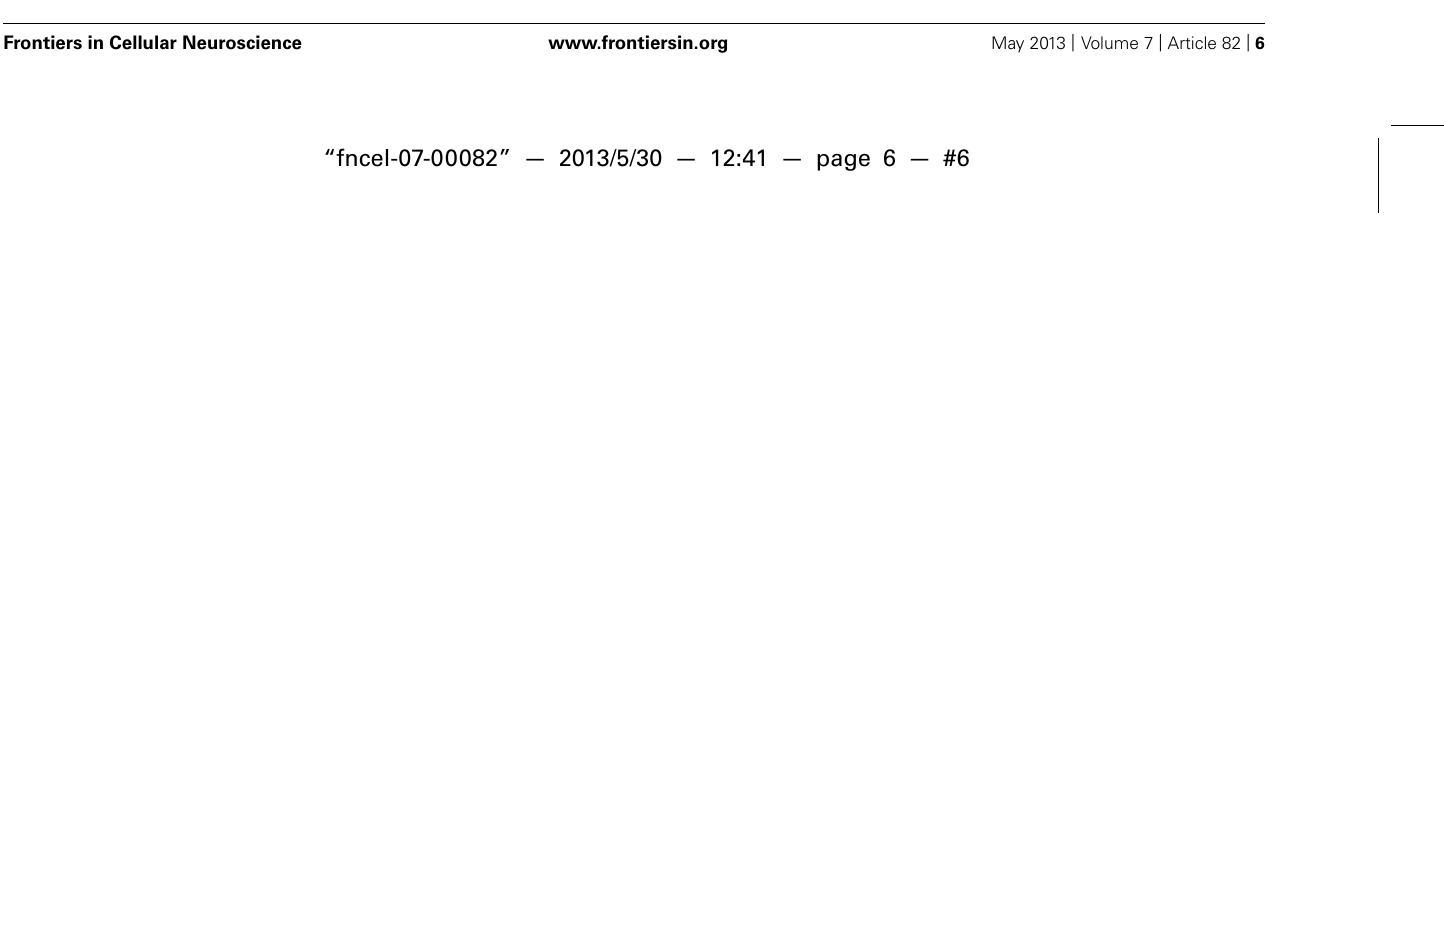
DAAM, dishevelled-associated activator of morphogenesis; DVL, dishevelled; FzR, frizzled receptor; GSK3, glycogen synthase kinase 3; JNK, c-Jun n-terminal kinase; LRP5/6, low-density lipoprotein receptor-related protein 5/6; NFAT, nuclear factor of activatedT cells; PKC, protein kinase C; PLC, phospholipase C; ROCK, Rho-associated protein